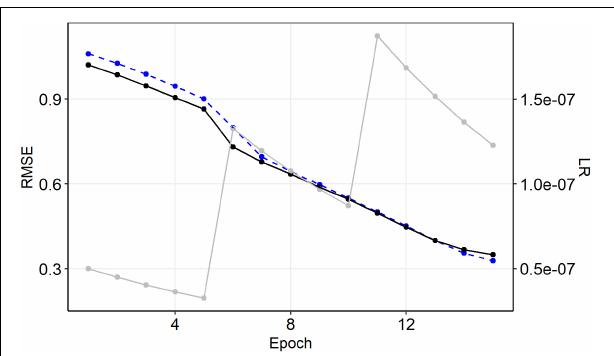
FIGURE 3 | History of model training. Black: validation, blue: training, gray: learning rate (sec.